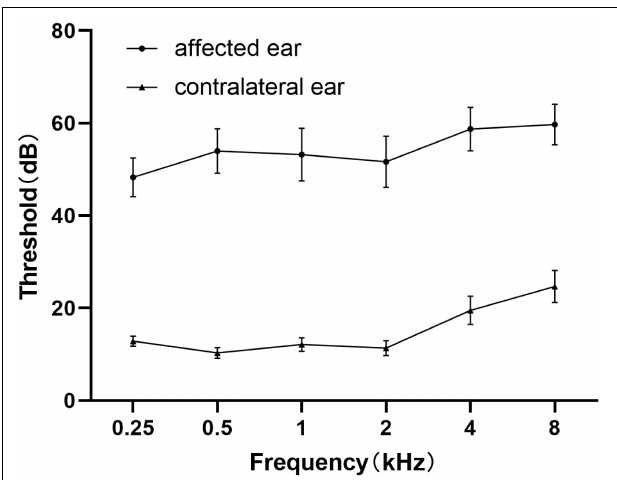
FIGURE 3 | Average pure tone audiograms for patients with SSNHL averaged over both ears at different frequencies. Data are presented as mean ± SEM. SEM, standard error of mean.